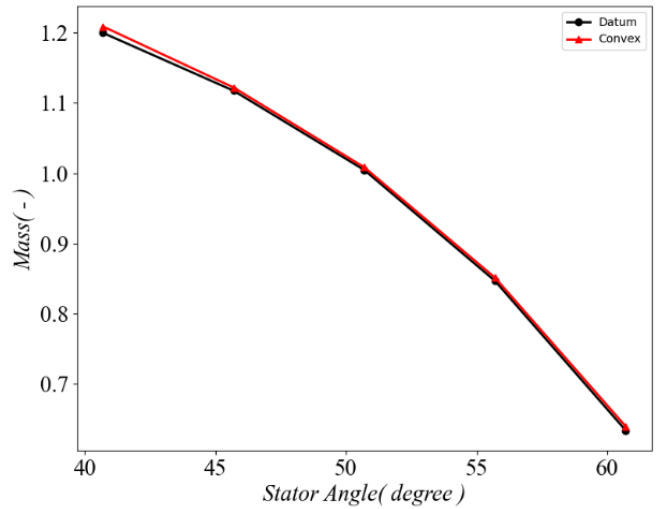
Figure 8. Mass flow rate versus the angle, at designed speed and pr.